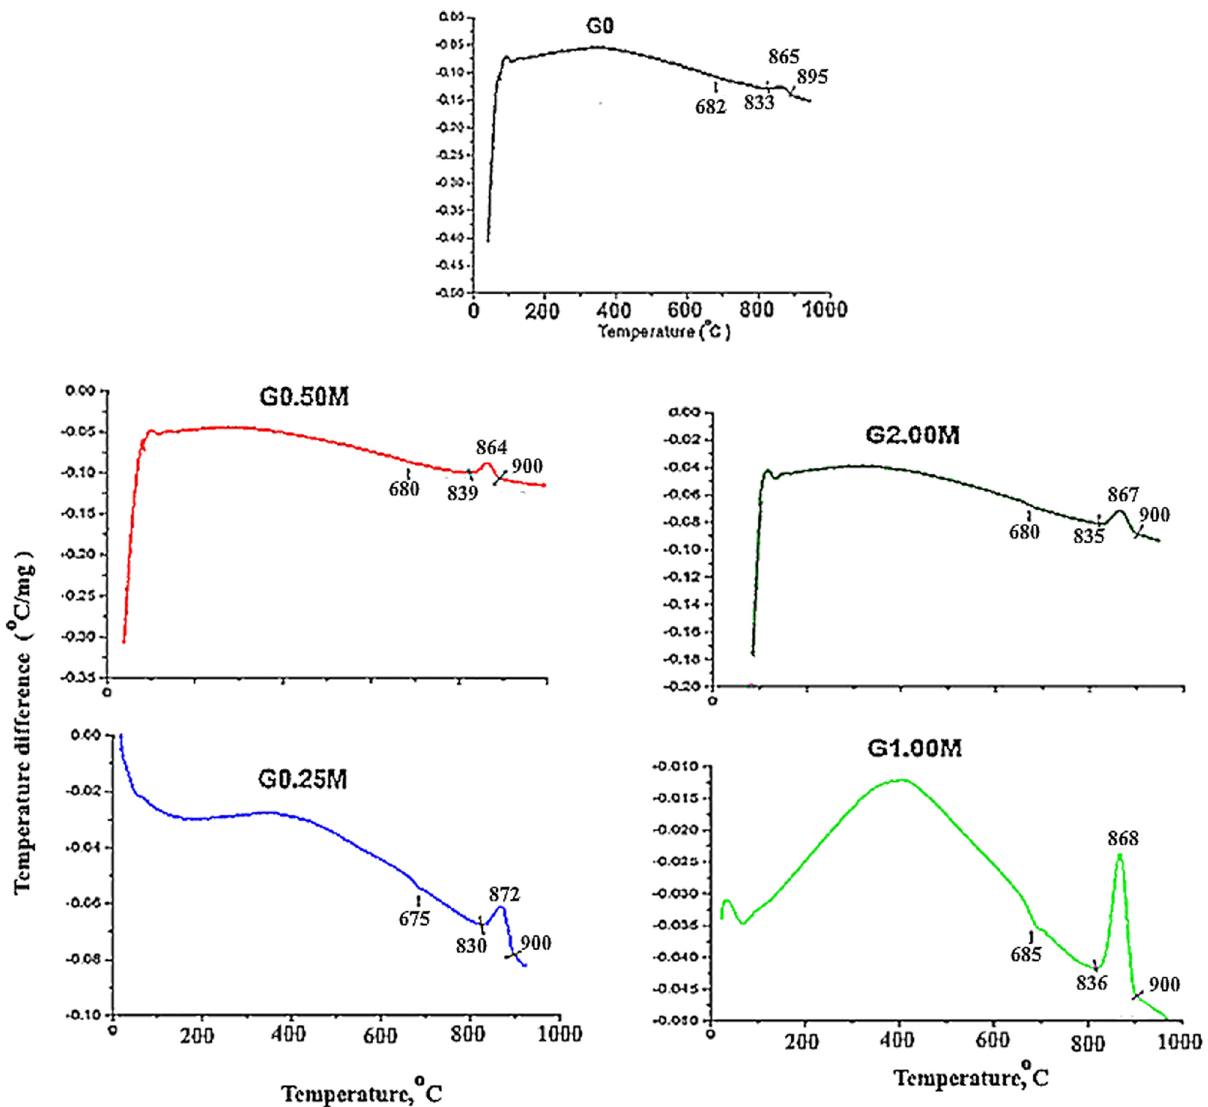
Figure 1: DTA thermograms of the glasses heated up to